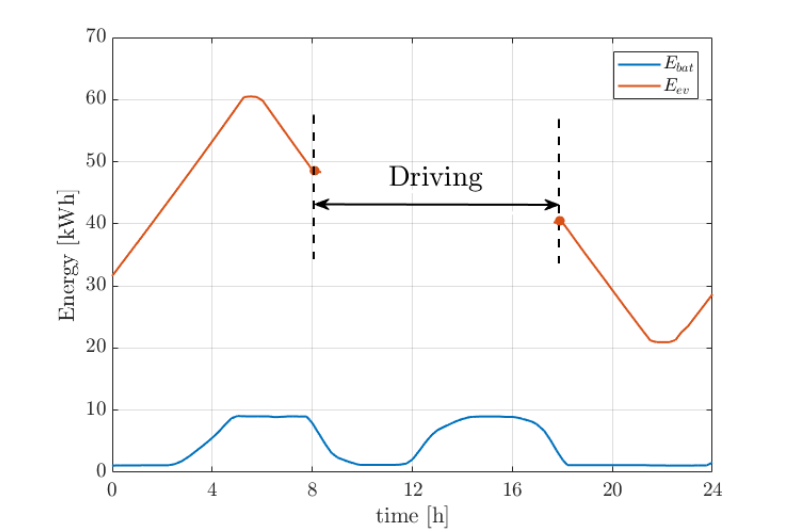
Figure 11. Resulting charge from optimized power flows inside electric vehicle and stationary storage for a winter